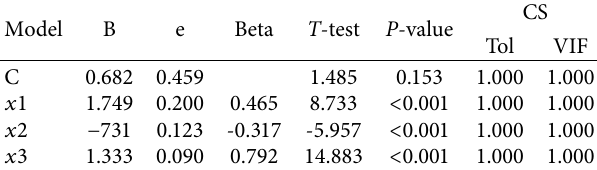
Table 7: Regression coefficient